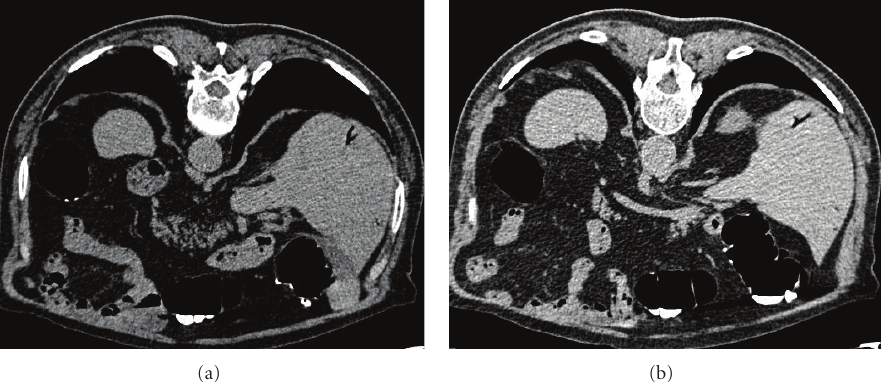
Figure 2: (a) Transverse CT scans revealed the presence of gas in both hepatic lobes. (b) Transverse CT scans revealed the presence of gas in both hepatic lobes.